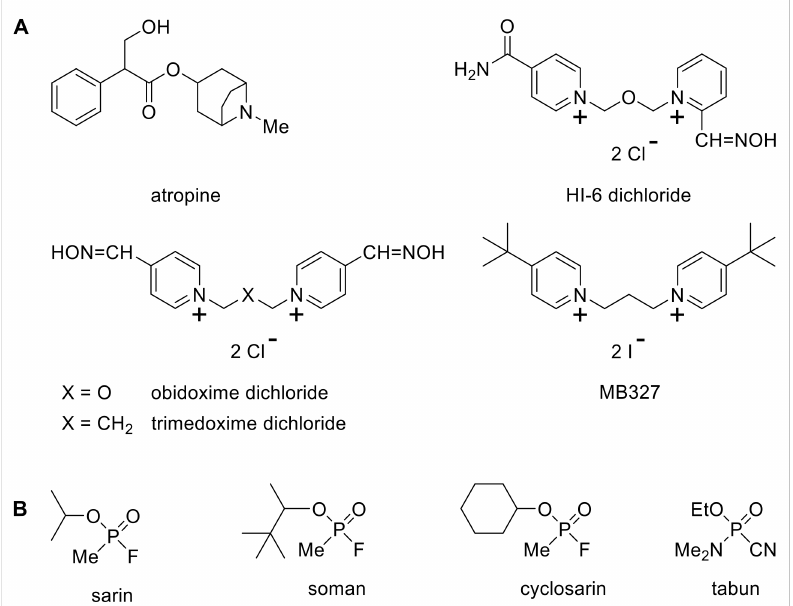
Figure 1. Components ( A ) of the therapies tested—the antimuscarinic atropine, the oximes HI- 6, obidoxime and trimedoxime, and the antinicotinic MB327—against the panel of nerve agents shown ( B